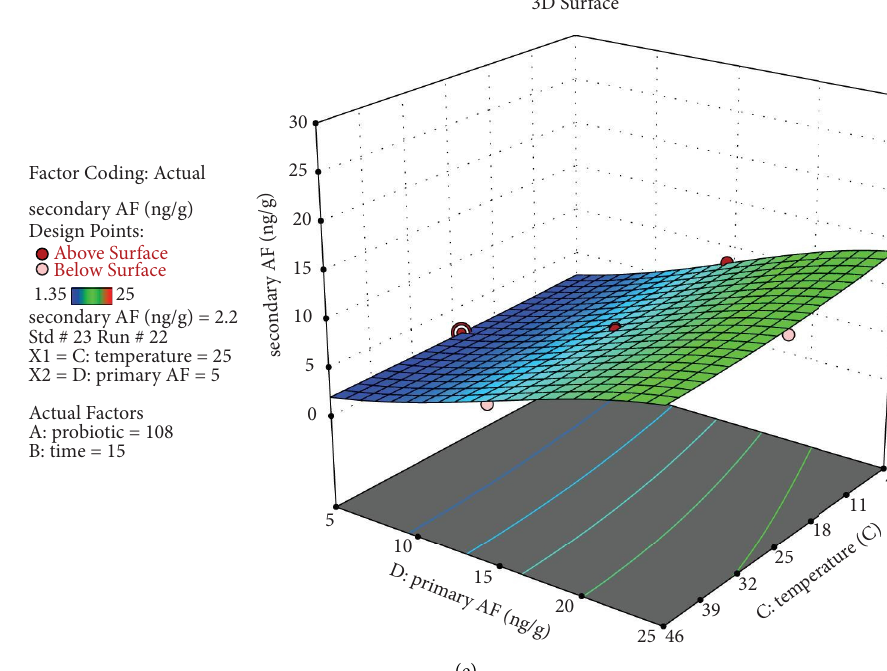
Figure 6: Interaction of probiotic content (10 8 CFU/g) and the storage time (15 days) on the afatoxin residue in pistachio